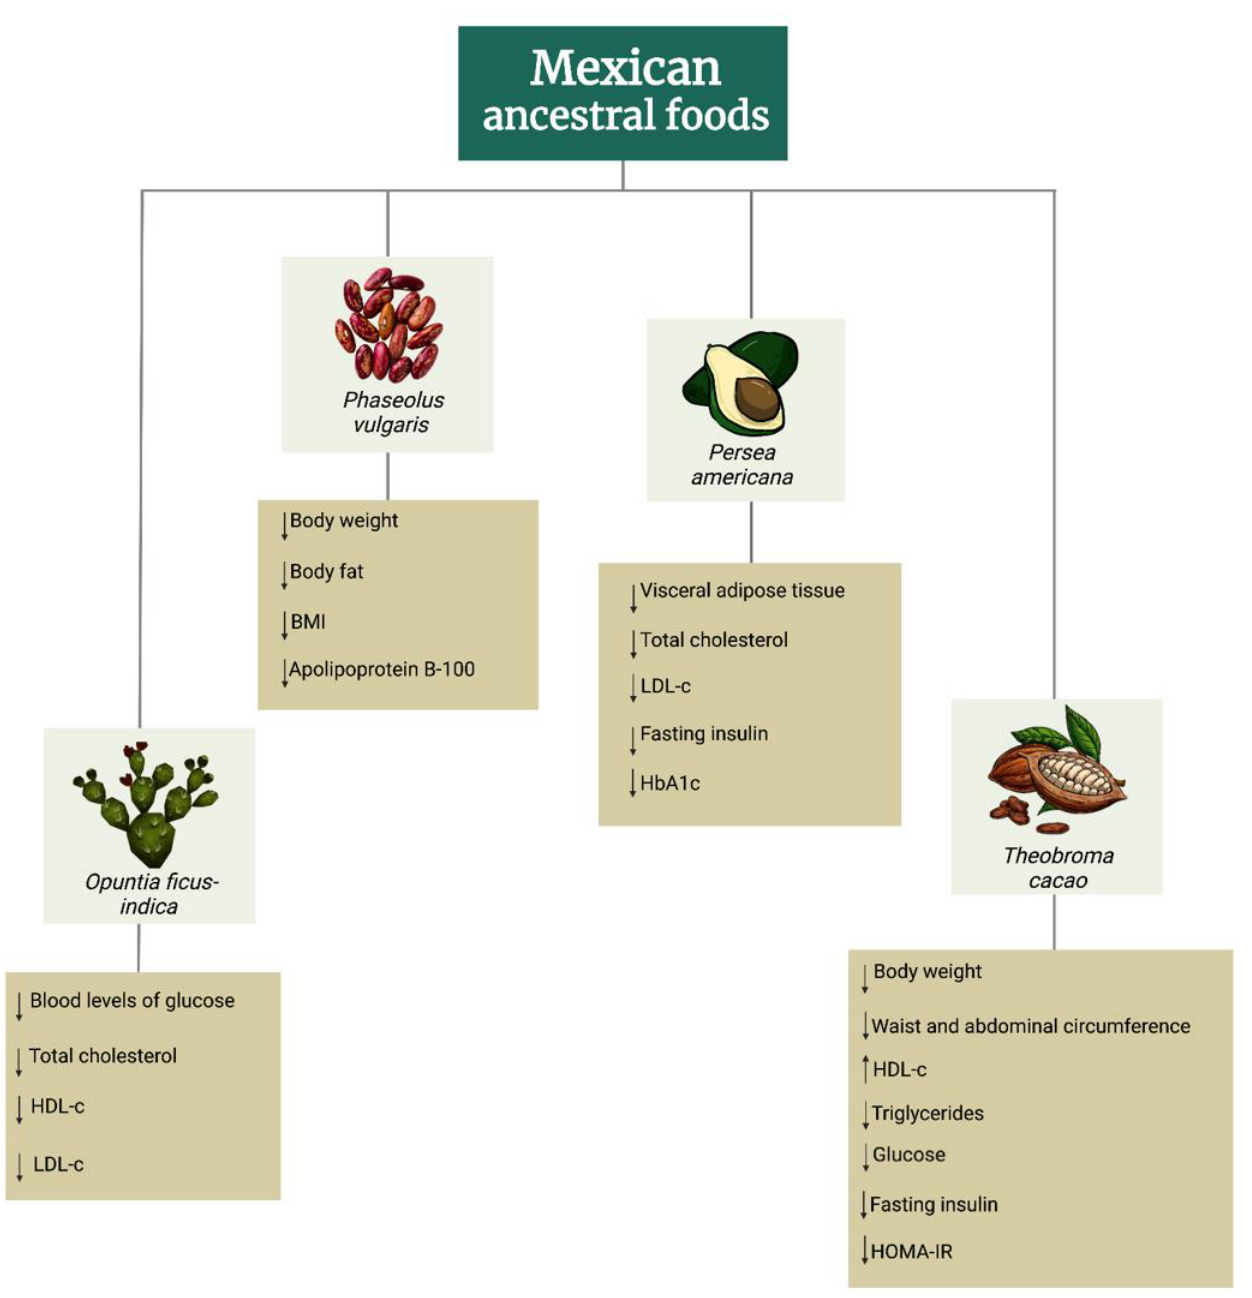
Figure 3. Effects of Mexican ancestral foods supplementation on obese patients [29,30,32,35,37–43]. BMI, body mass index; LDL-c, low density lipoprotein cholesterol; HDL-c, high density lipoprotein cholesterol; HbA1c, hemoglobin A1c; HOMA-IR, homeostatic model assessment for insulin resistance. ↓ diminution in control variables; ↑ increase in control variables